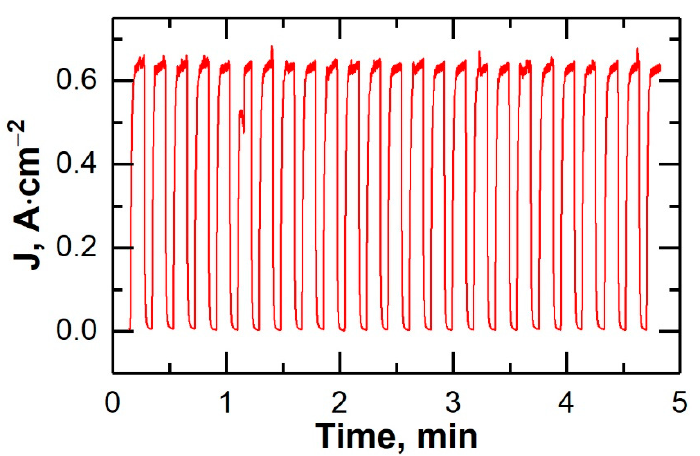
Figure 12. Thermal cycling performance of the microtubular oxygen pump between 400 and 800 °C at the voltage of 0.5 V.